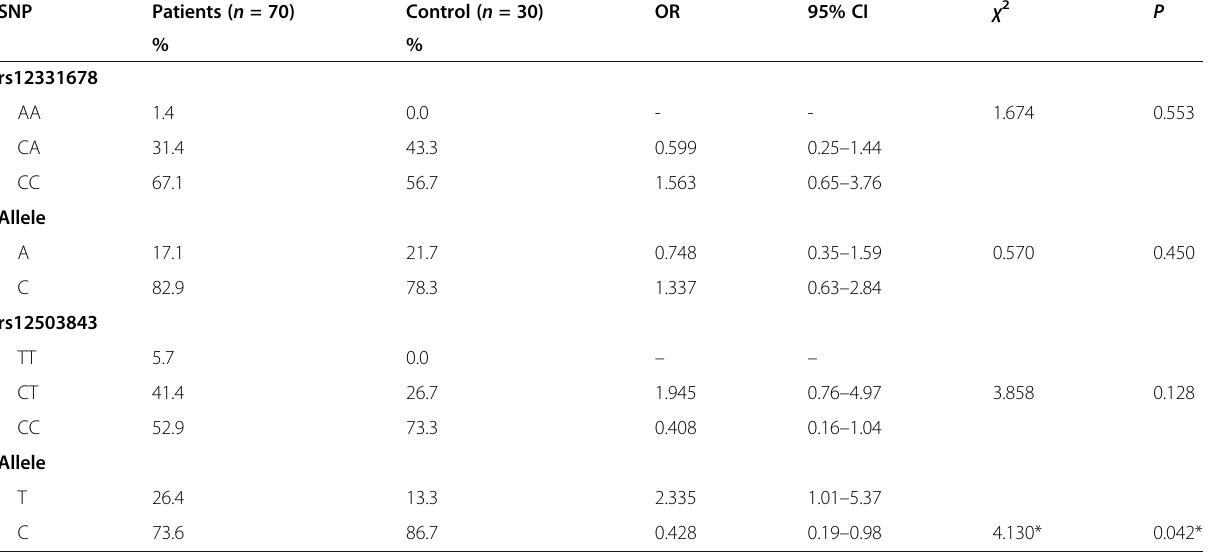
Table 2 Genotypic and allelic frequencies of HPSE SNP in HCC and control